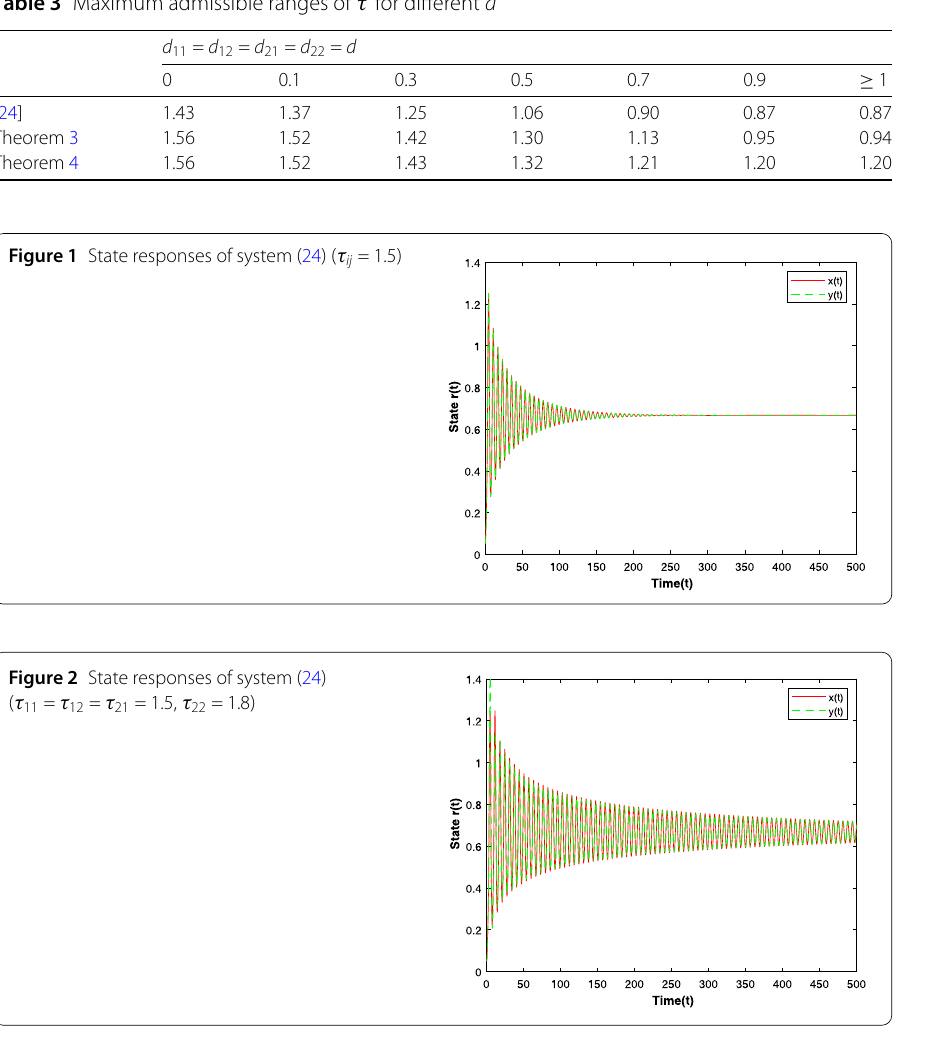
Table 3 Maximum admissible ranges of τ for different d